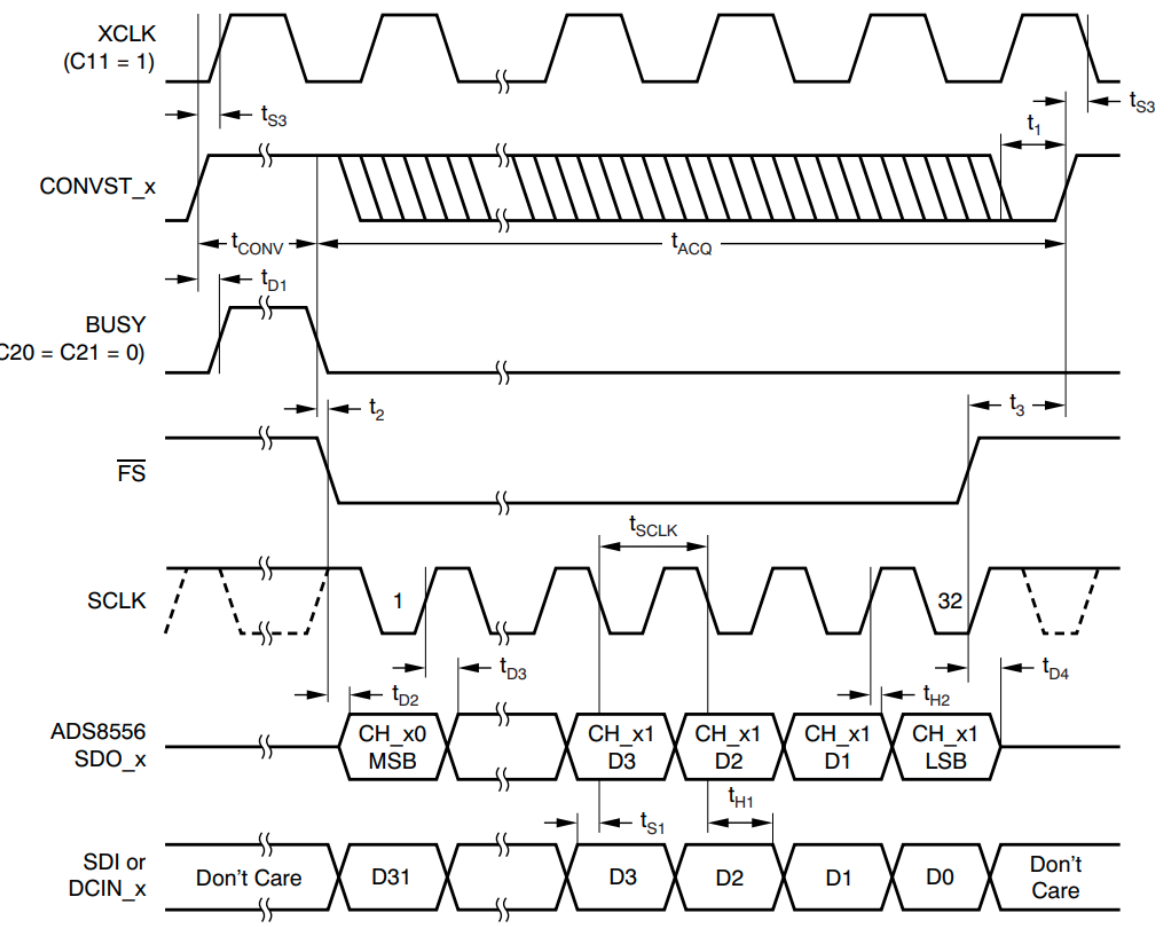
Figure 3. Example of an “on-the-clock true” application: a timing diagram for serial operation of the ADS8586S ADC chip from Texas Instruments [10]. Each of the time intervals indicated on the diagram has a specified maximum or minimum value constraint or, sometimes, both. Not meeting those constraints may cause a glitch in the proper operation of the peripheral or might even render it totally dysfunctional. In addition, the sampling clock must be jitter free. Even a single clock tick variation on the sampling clock will have a detrimental effect on the ENOB of the acquired data. This level of real-time behavior sets very high requirements for the controlling system, especially when combining this with other functionalities. Courtesy of Texas Instruments